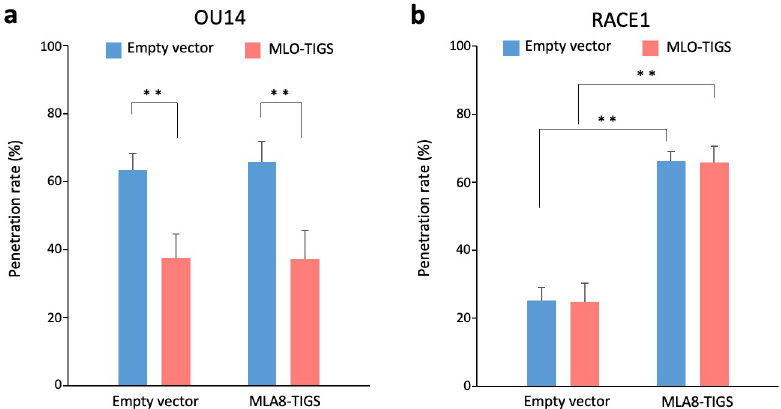
Fig 5. RACE1 overcome the penetration resistance in Golden Promise epidermal cells in which MLO and MLA8 expression was suppressed. Penetration rates of OU14 ( a ) and RACE1 ( b ) were examined in MLO-TIGS- and MLA8-TIGS-introduced epidermal cells of Golden Promise ( Mla8 ). The empty pANDA-mini vector was introduced as a negative control. Error bars represent standard deviation (n = 3). The mean values of these experiments were calculated from independent experimental data obtained from 2–10 introduced leaves. �� , P < 0.01 (Student’s t -test).